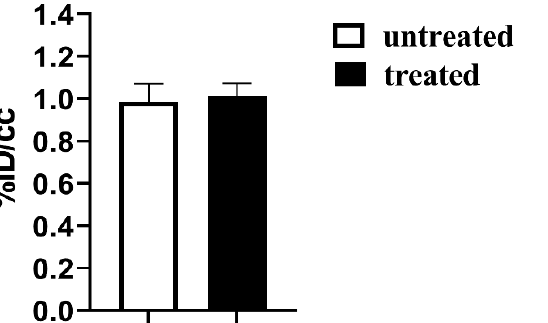
Figure 6. FDG-PET glucose %ID/cc uptake values for the subcutaneous PC3 tumor murine model after one week of treatment with Esomeprazole (dose: 2.5 mg/kg b.w., every other day by gavage) for untreated (N = 3, white bar) and treated (N = 3, black bar) mice.